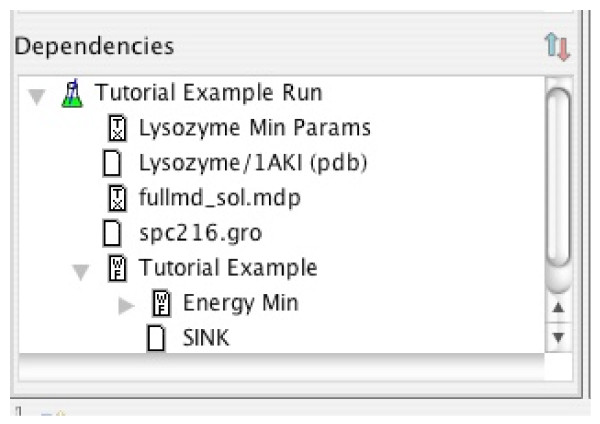
Dependency View.